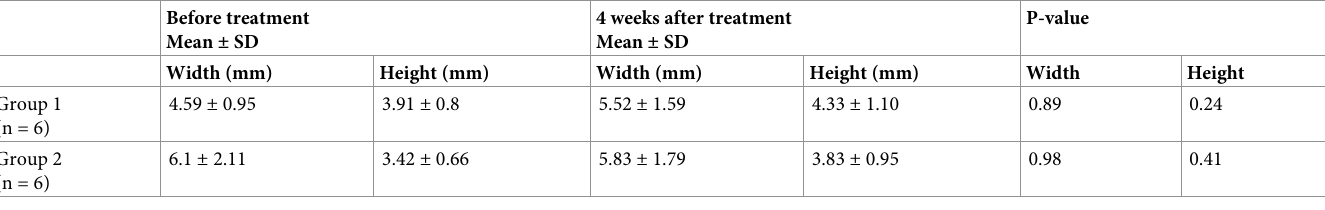
Table 1. Mean values of medial iliac lymph nodes size at each time point and comparison between time